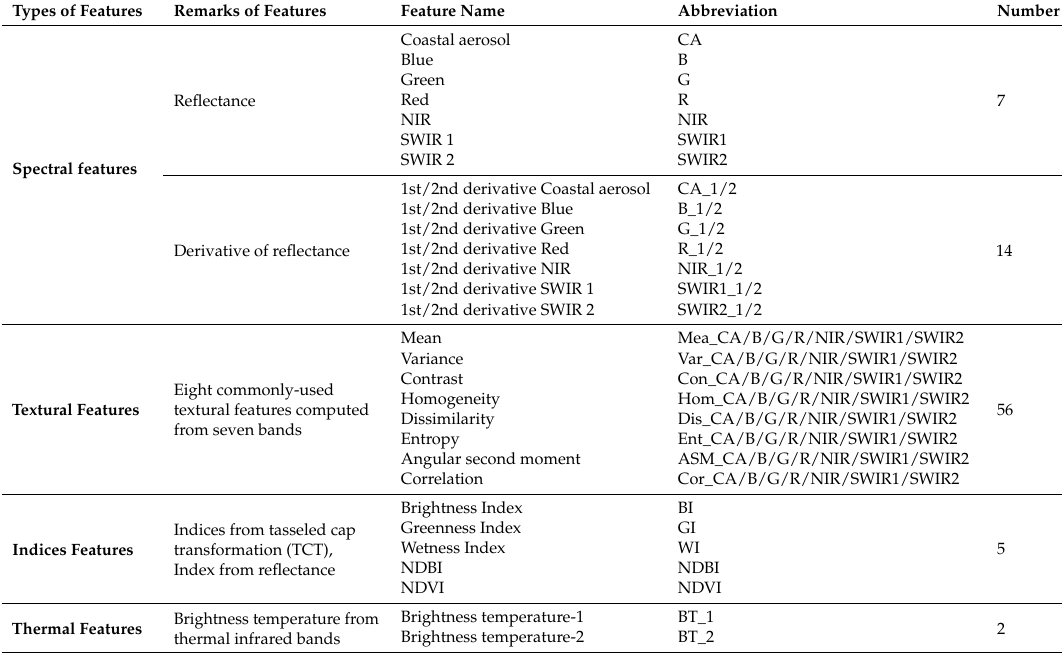
Table 2. The extracted features from a single temporal Landsat-8 image. NDBI: normalized difference built-up index; NDVI: normalized difference vegetation